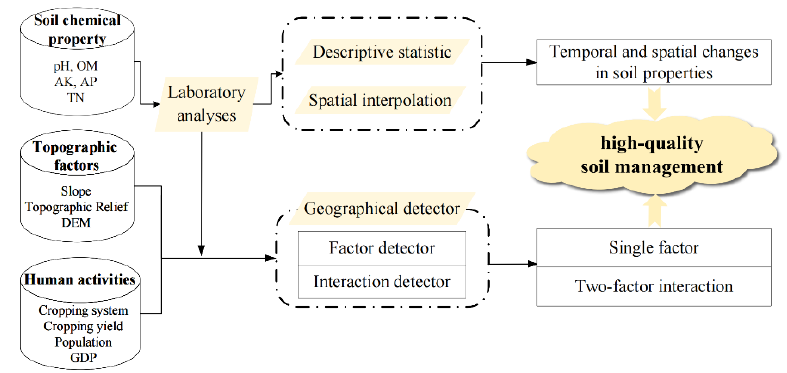
Figure 1. Research Framework.